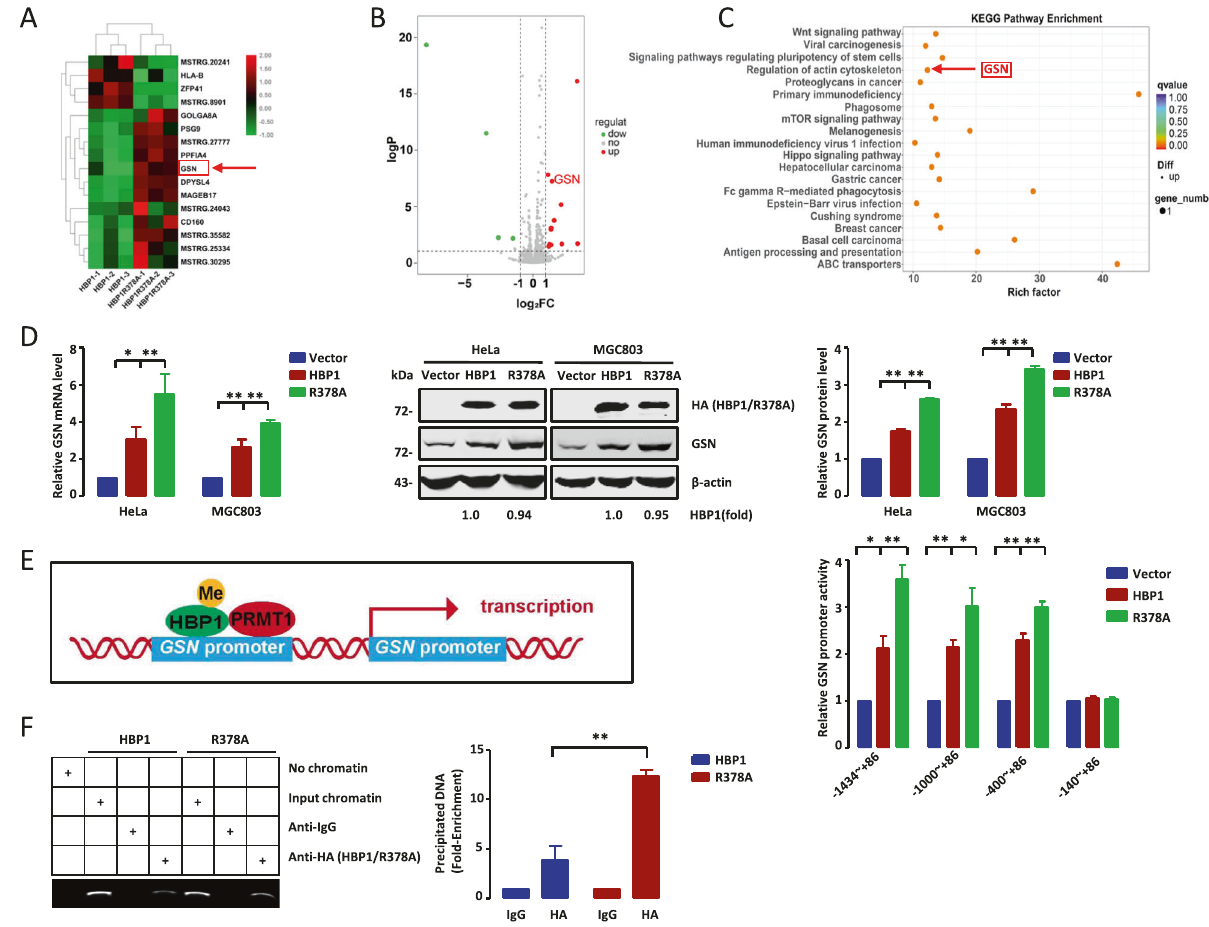
Fig. 5 HBP1 methylation alleviates its transcriptional activation of GSN . A – C RNA-seq analysis found that 16 genes were differentially expressed in HeLa cells transfected with HBP1 or R378A. Heatmap ( A ) and volcano plot B showed 16 differentially expressed genes between HBP1 and R378A expressing cells with RNA-seq analysis. KEGG enrichment analysis revealed 16 genes enriched in different biological pathways C . D Methylation of HBP1 at R378 alleviates HBP1 promotion of GSN mRNA and protein levels. GSN mRNA and protein levels were measured with real-time PCR and western blotting in HeLa and MGC803 cells transfected with empty vector, HBP1 or R378A. E , F Methylation of HBP1 at R378 alleviates its transcriptional activation on GSN . E HEK293T cells were co-transfected HBP1 or R378A with different GSN promoter segment. The luciferase activities were expressed (right panels). F ChIP assay was used to test HBP1 direct binding to GSN promoter. HEK293T cells were transfected with HBP1 or R378A. Speci fi c binding of HBP1 or R378A to GSN promoter ( − 400 to − 140) were measured by speci fi c PCR (left panel) and real-time PCR (right panel). IgG was used as a negative control. Date were the mean ± SD ( n = 3, one-way ANOVA). * p < 0.05, ** p <